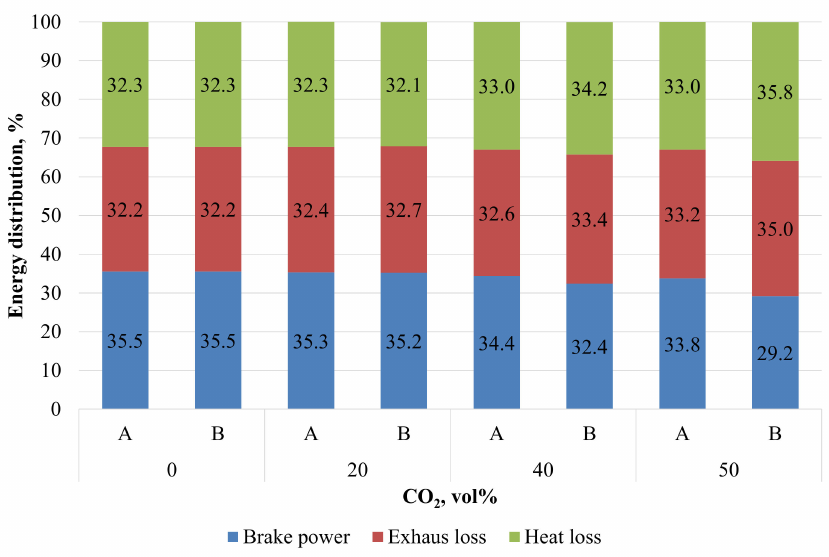
Figure 4. Energy distribution. A—with optimal ST; B—with constant ST.